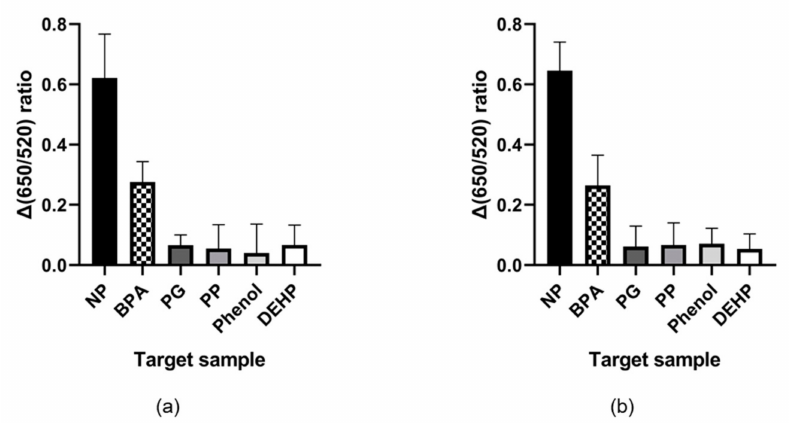
Figure 4. Specificity of NP7 against other EDCs and similarly structured chemicals in the AuNP colorimetric assay in ( a ) tap water and ( b ) 0.1% domestic detergent